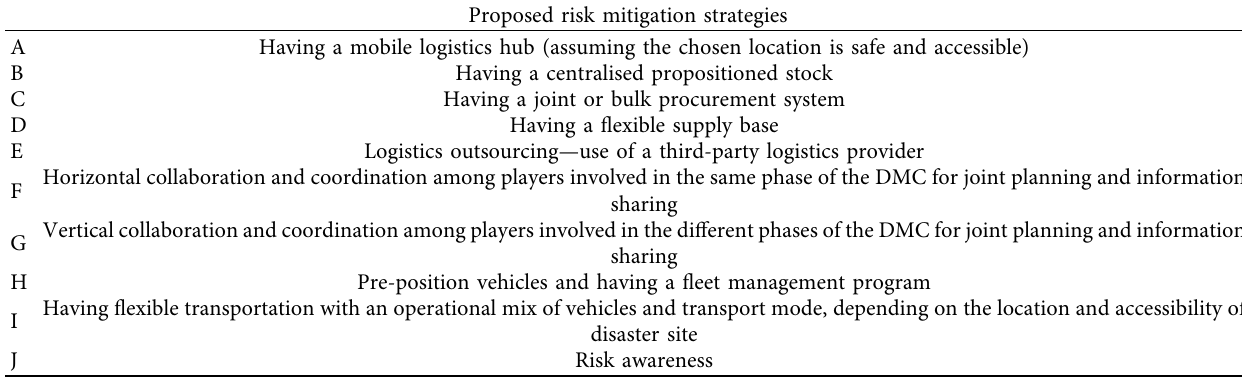
Table 2: Proposed supply chain strategies for mitigating risk in the DMC (adapted from